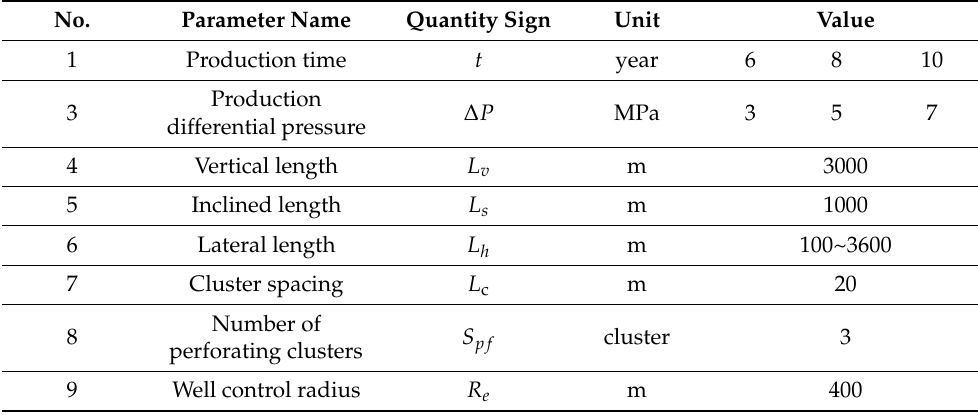
Table 3. Technical parameters of the shale-gas horizontal